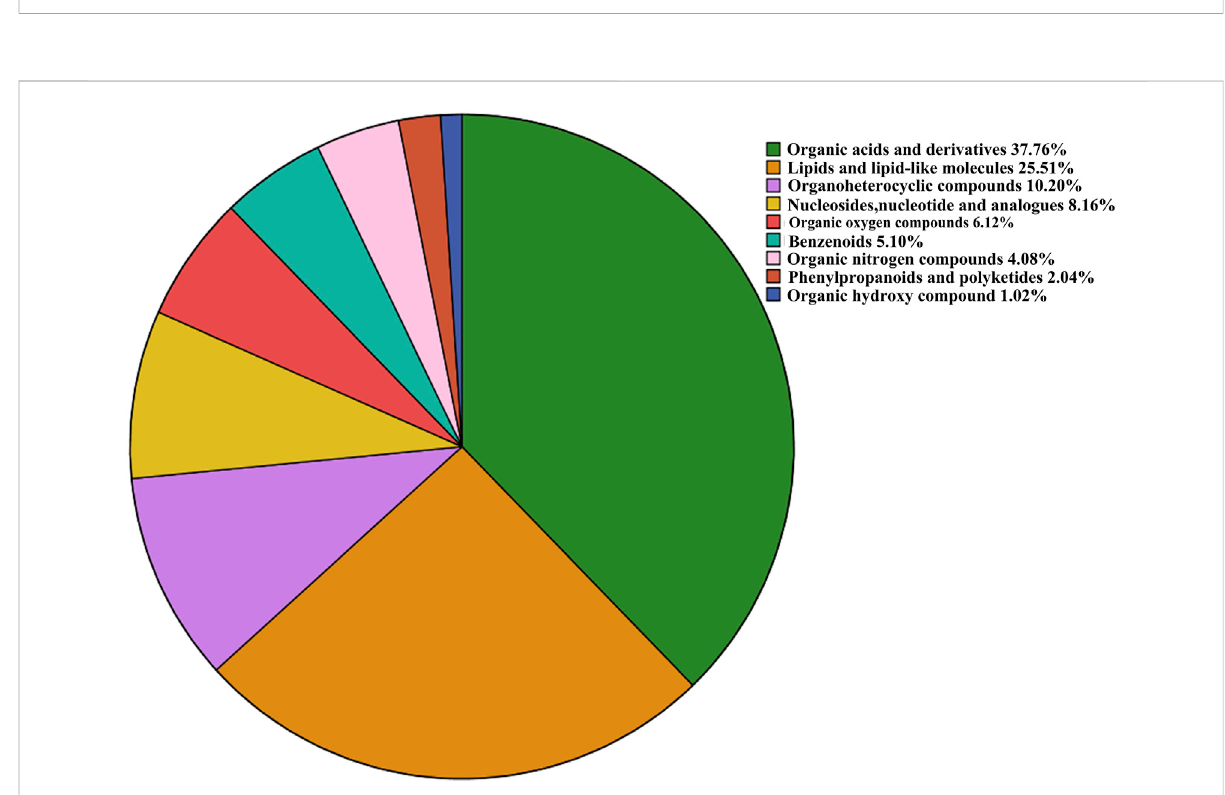
FIGURE 3 Proportion of identi fi ed metabolites in each chemical classi fi